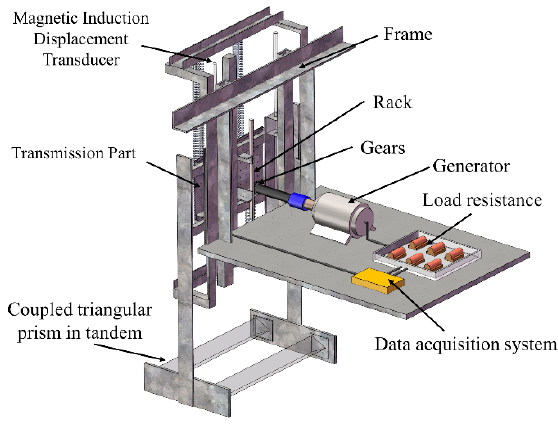
Figure 4. Schematic of energy conversion system.